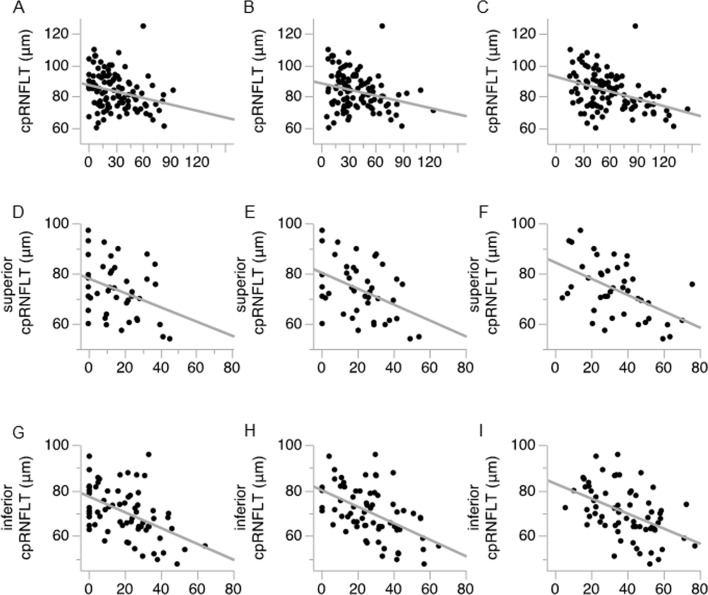
Association between RNFLD angle and cpRNFLT.Scatter plot showing the correlation coefficient between RNLDA and cpRNFLT in the en-face image 1 (A), en-face image 2 (B), and en-face image 3 (C). (D-F) Correlation between RNFLDA and cpRNFLT in the inferior hemifield. (G-I) Correlation between RNFLDA and cpRNFLT in the superior hemifield.